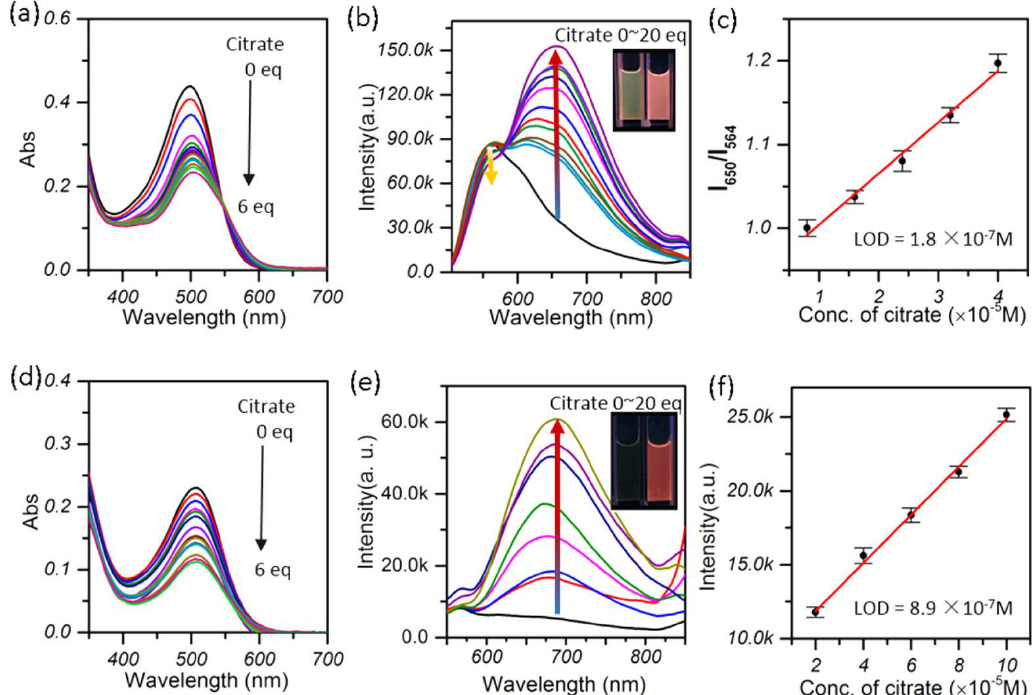
Figure 12. Spectrophotometric titration of F4a ( a ) and F4b ( d ); and spectrofluorometric titration of F4a ( b ) and F4b ( e ) with increasing amount of citrate. Inserts in ( b ) and ( e ): photos showing emission changes to the two sensors in response to citrate. The plot of fluorescence intensities as a function of citrate concentration for F4a and F4b are shown in ( c ) and ( f ), respectively. Reproduced with